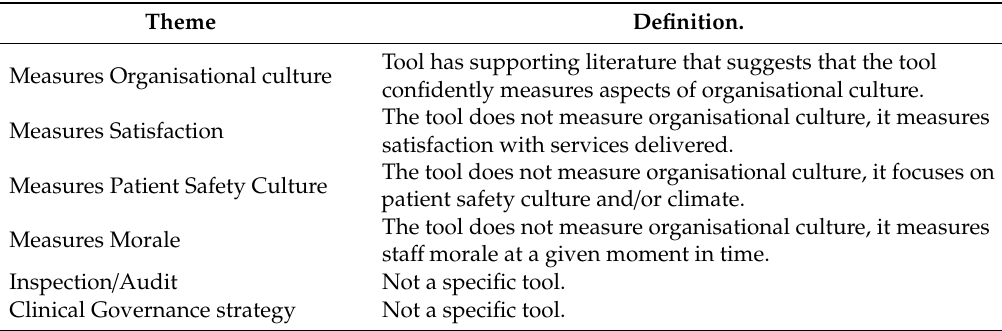
Table 2. Global themes